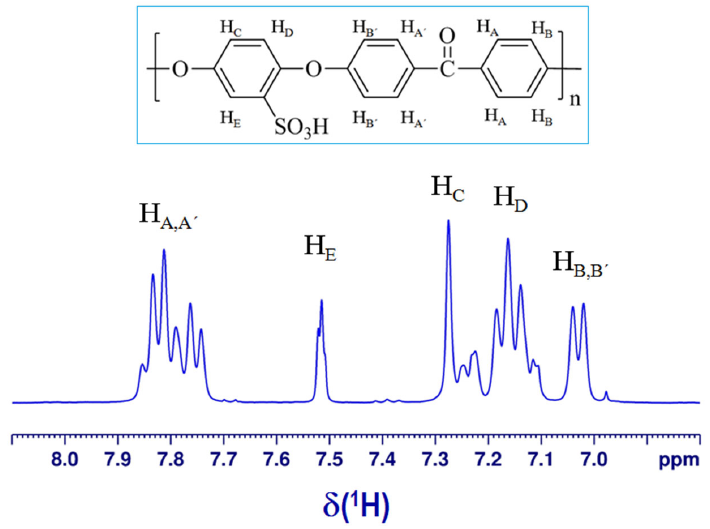
Figure 3. 1 H ‐ NMR spectrum of the SPEEK sample recorded in deuterated solvent (DMSO ‐ d6).